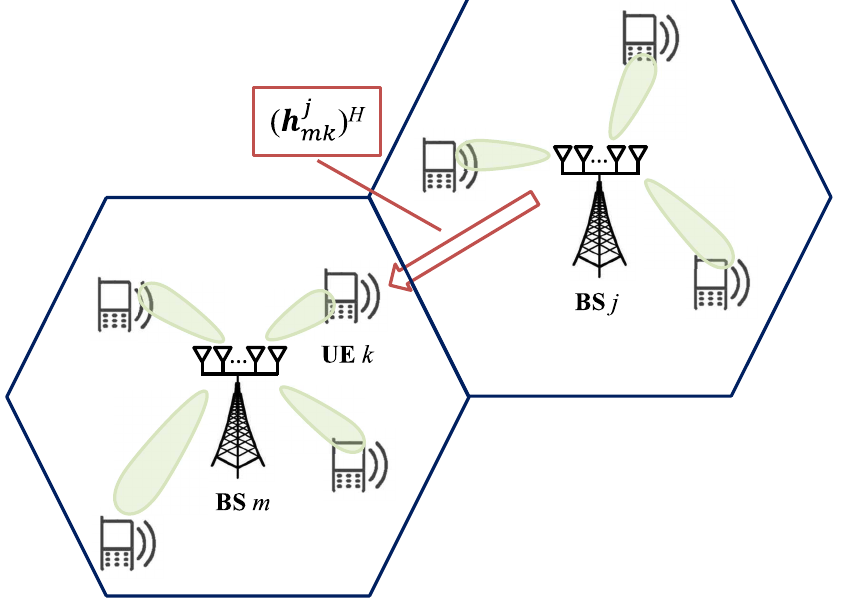
Figure 1. Downlink multi-cell massive MIMO